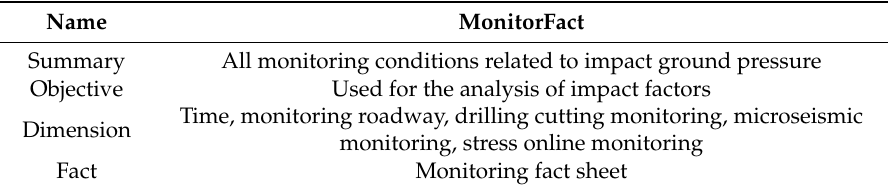
Table 4. MonitorFact fact table metadata.